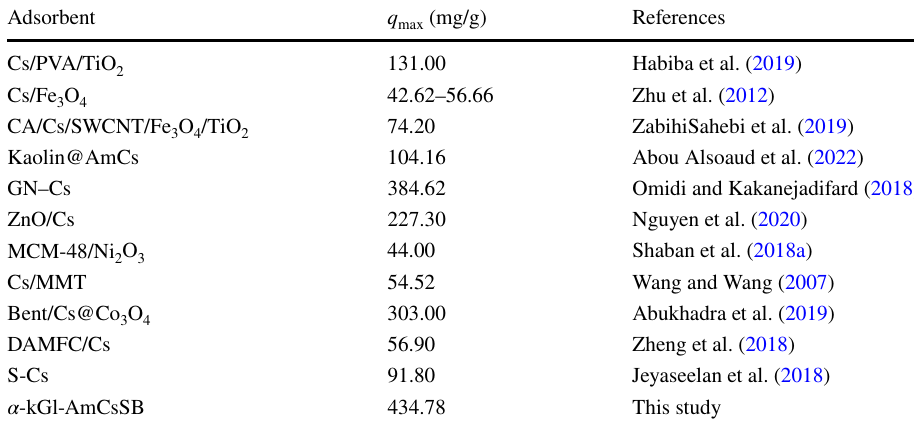
Table 3 Comparison between the adsorption performance of α -kGl-AmCsSB composite and other relevant adsorbents toward the CR adsorption